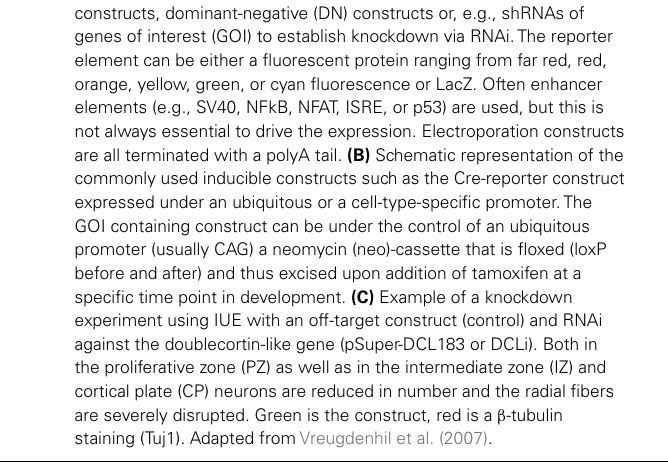
constructs, dominant-negative (DN) constructs or, e.g., shRNAs of genes of interest (GOI) to establish knockdown via RNAi.The reporter element can be either a fluorescent protein ranging from far red, red, orange, yellow, green, or cyan fluorescence or LacZ. Often